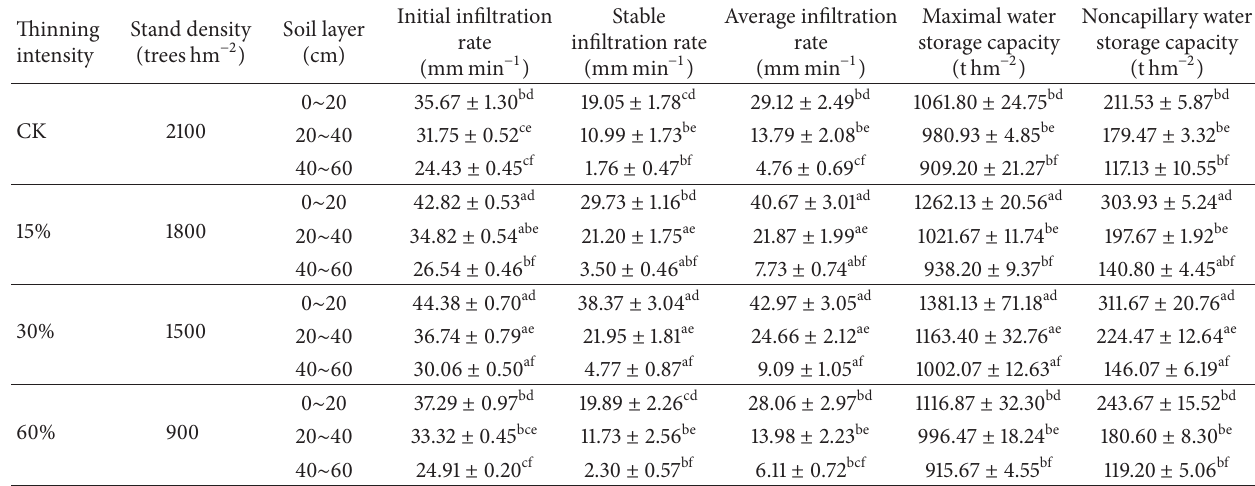
Table 4: Characteristics of soil infiltration rate and water storage